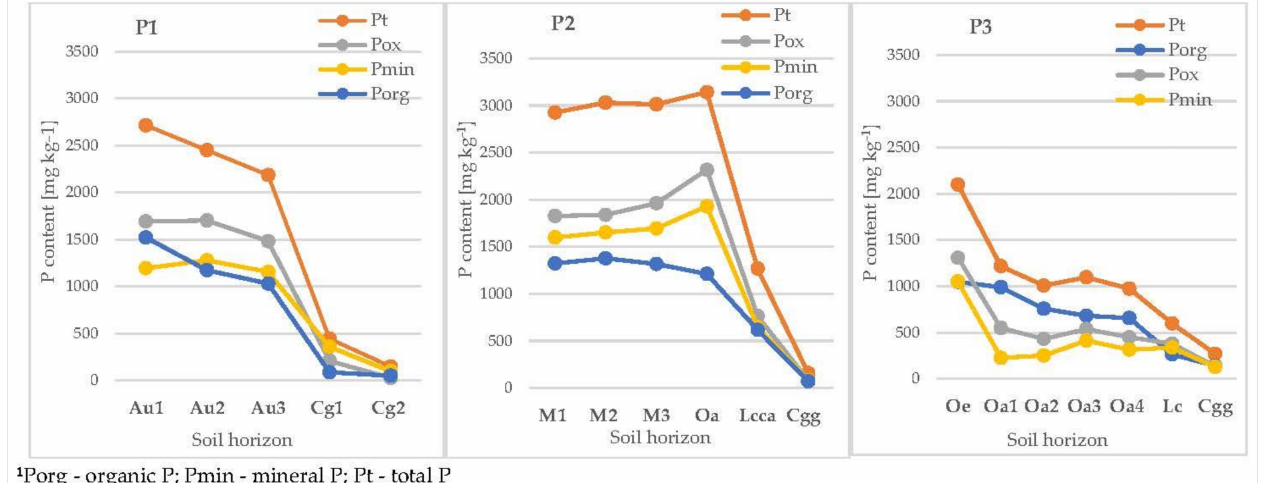
Figure 4. Quantitative relationships between P forms in the studied soils: Pt 1 , Pox, Pmin, Porg; Pox—soil oxalate